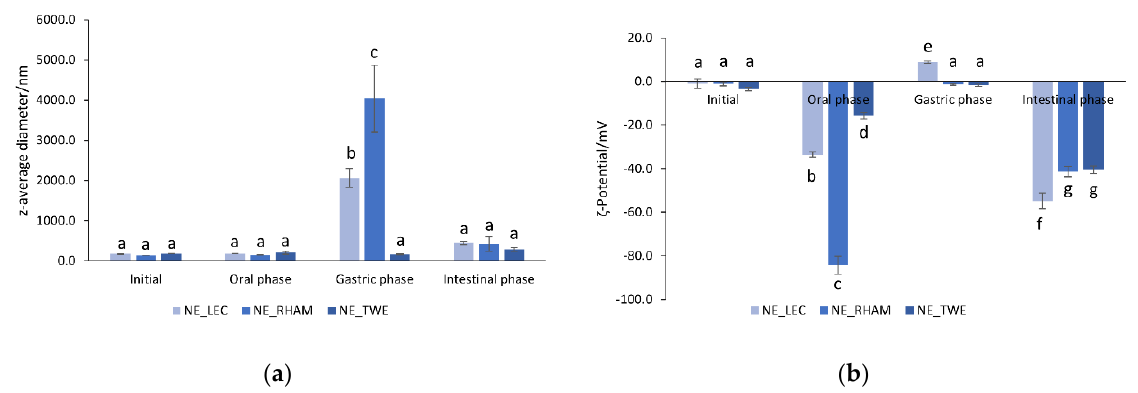
Figure 2. Particle size ( a ) and ζ -potential ( b ) of nanoemulsions (NEs) with different emulsifiers (lecithin (LEC), rhamnolipids (RHAMs), and Tween ® 80 (TWE)) in the different in vitro gastrointestinal digestion phases. Error bars represent the standard deviation of n = 3 replicates. a–g Different lower-case letters indicate a statistically significant difference between NEs in the different GI) phases ( p < 0.05).